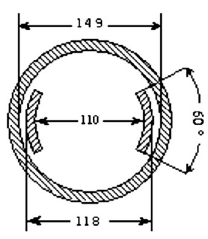
FIG. 7. Cross section of the Recycler stripline detector; dimensions in mm